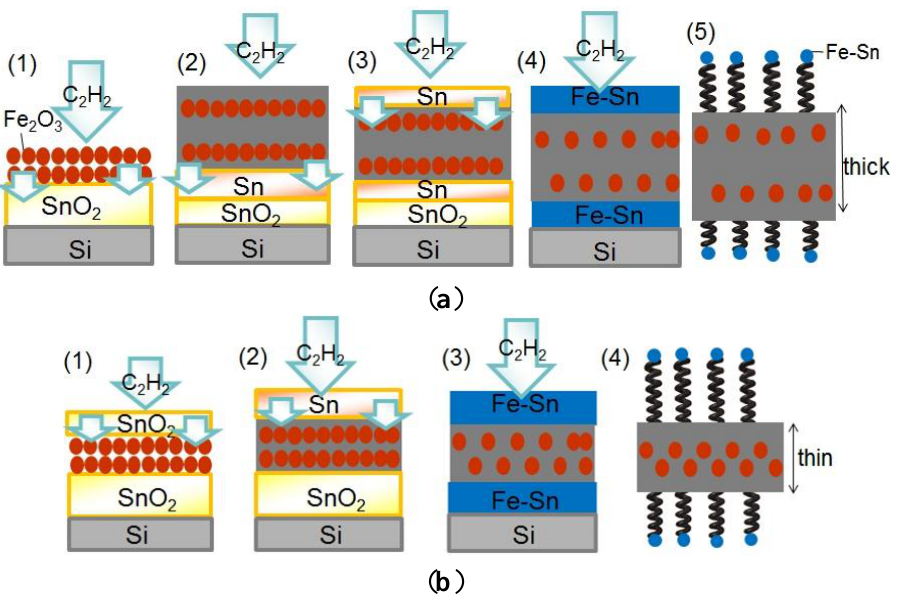
Figure 10. Growth models of ( a ) Fe 2 O 3 /SnO 2 and ( b ) SnO 2 /Fe 2 O 3 /SnO 2 catalyst